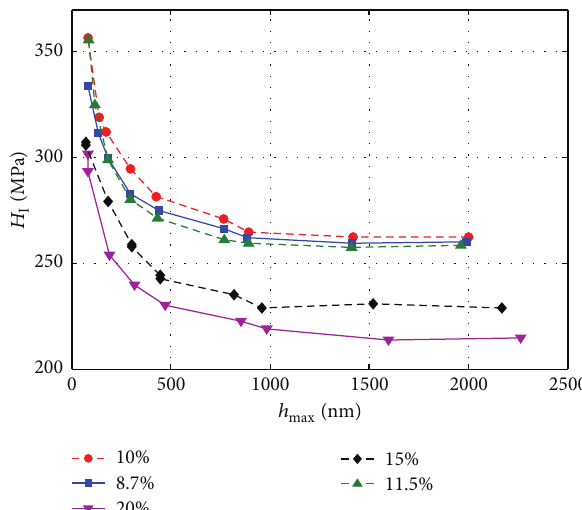
Figure 8: Indentation hardness of epoxy with different hardener contents as a function of indentation depth ℎ max